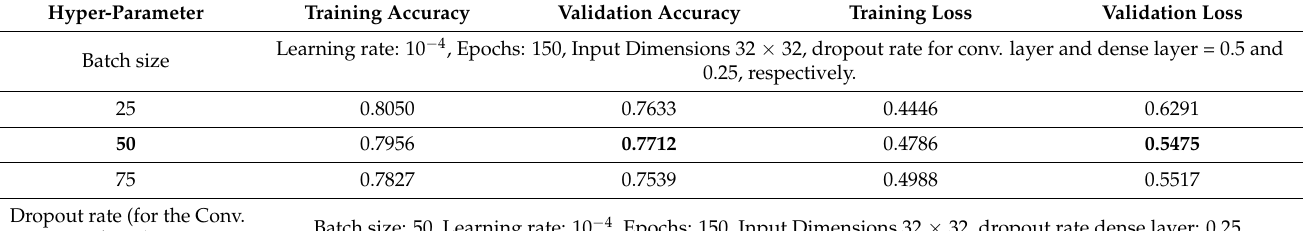
Table 3. Hyper-parameter tuning.